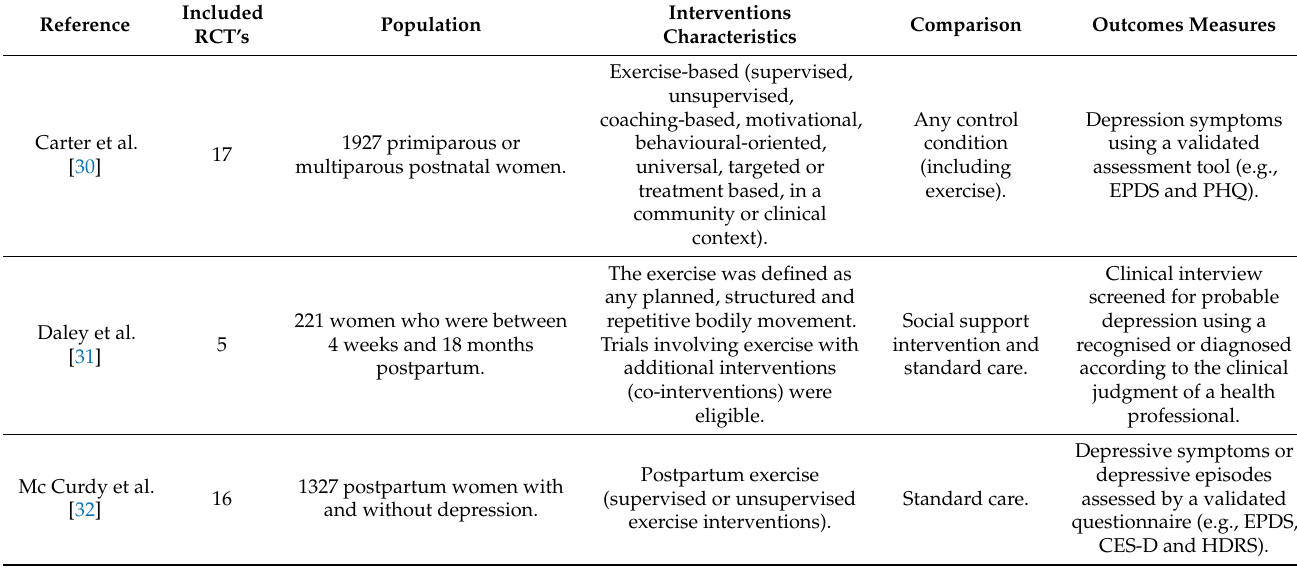
Table 1. Summary of the meta-analyses included in the current study following the PICO search strategy.